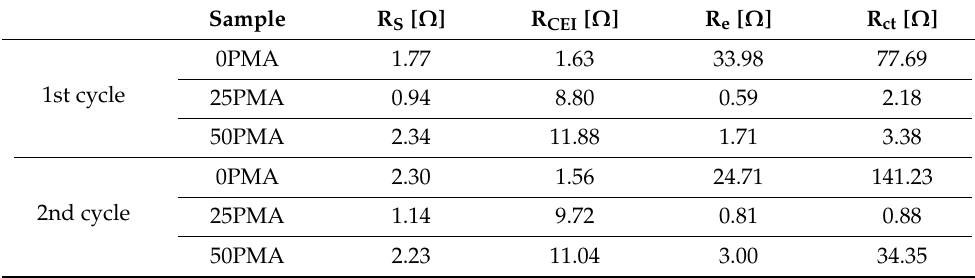
Figure 9. Comparison of contributions ( a ) R S , ( b ) R CEI , ( c ) R e and ( d ) R ct to resistance of 0PMA, 25PMA and 50PMA cells at 100%DOD. Table 5. Resistance parameters determined form fitting the equivalent circuit model to the